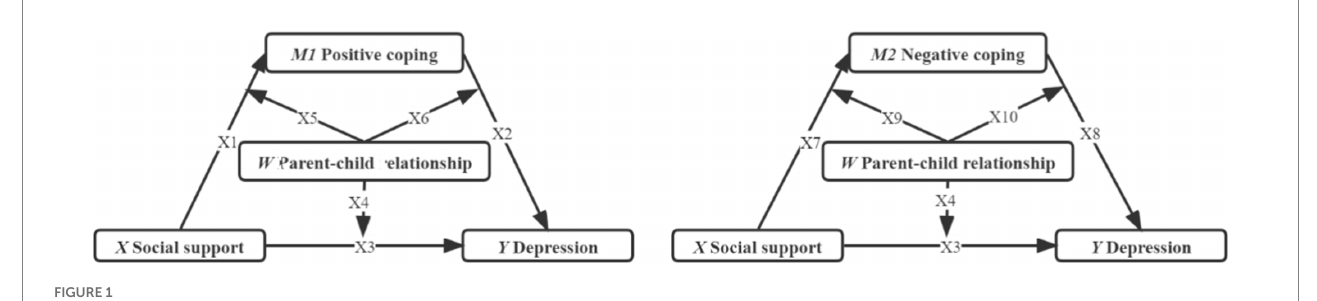
FIGURE 1 Hypothetical model: moderating mediator